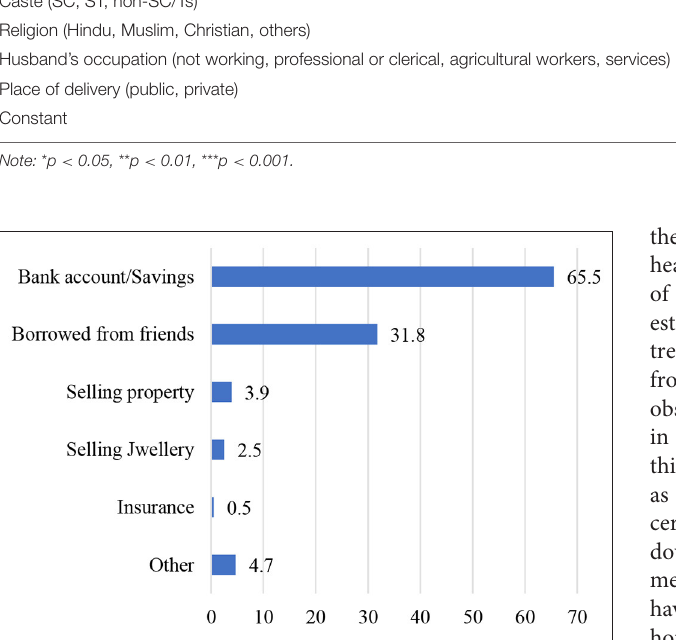
FIGURE 8 | The nature of out-of-pocket cost (in rupees) paid for delivery for the most recent live birth among women aged 15–49 years in India by the poorest quantile,